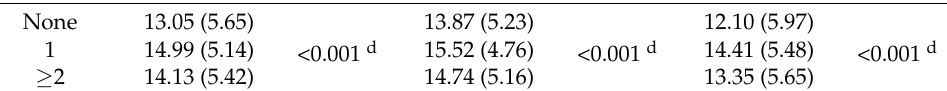
sample t -test, d —outcomes of one-way ANOVA